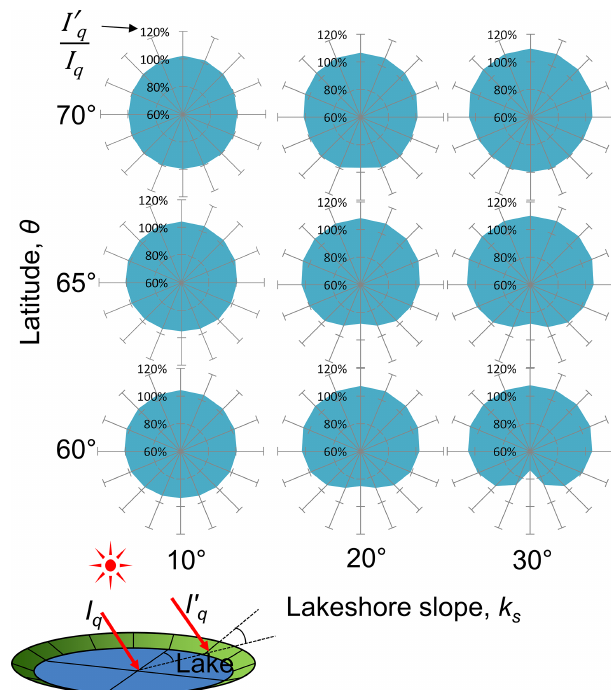
Figure 7. Computed mean daily potential solar radiation on slop- ing lakeshore relative to the flat surface during the summer period (June–August) with respect to latitude. I q is the potential solar radi- ation on a flat surface, and I (cid:48) q is radiation on the sloping lakeshore.